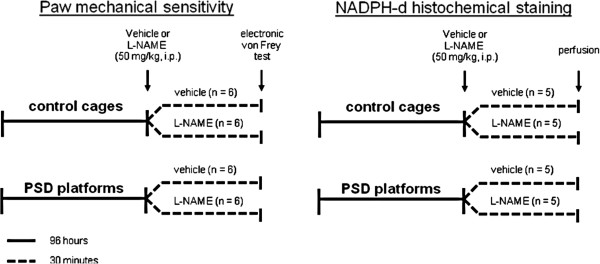
Course of study.